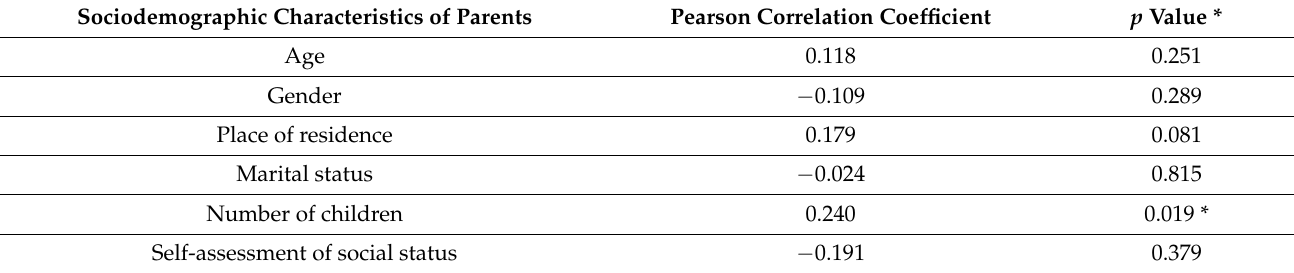
Table 4. The correlation between experienced stress and sociodemographic characteristics of the